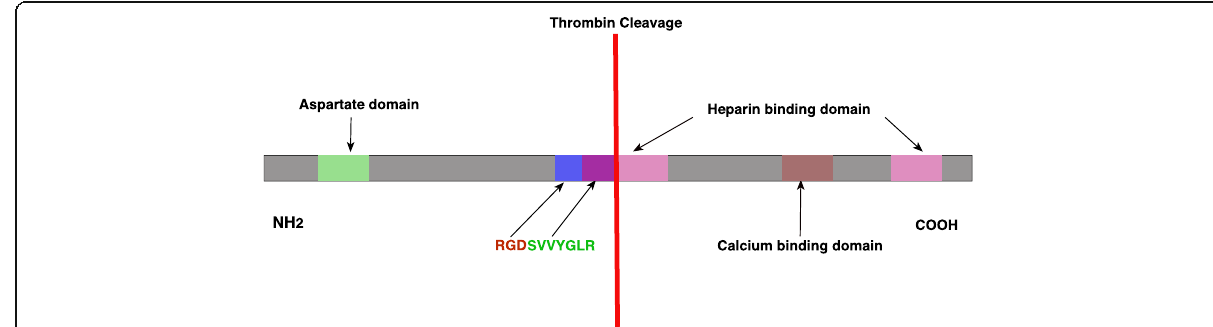
Fig. 1 A schematic representation of osteopontin structure and thrombin cleavage site. RGD (arginine-glycine-aspartic acid) and SVVYGLR (serine-valine-valine-tyrosine-glutamate-leucine-arginine) binding domains are